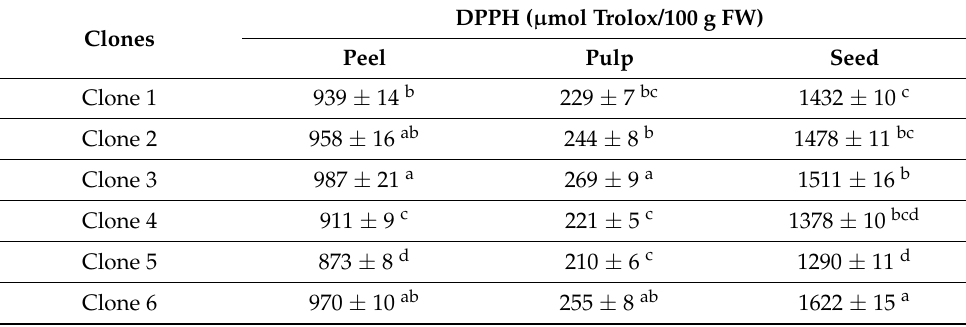
Table 3. DPPH assay results of six ‘Köhnü’ grape